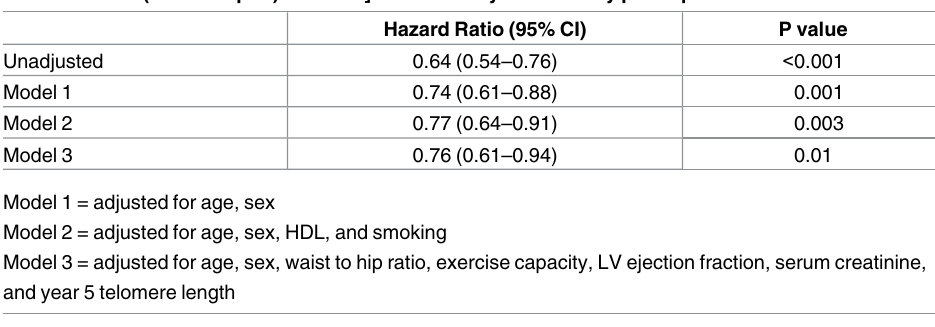
Table 3. Association between 5-year telomere change [entered as a continuous variable, per stan- dard deviation (325 base pair) increase] and mortality in 608 study participants.